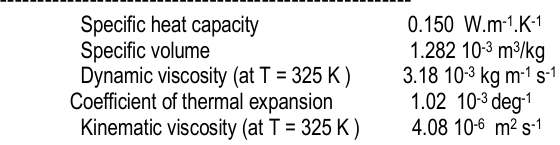
Tab. V n- eicosane n-Eicosane LIQUID properties